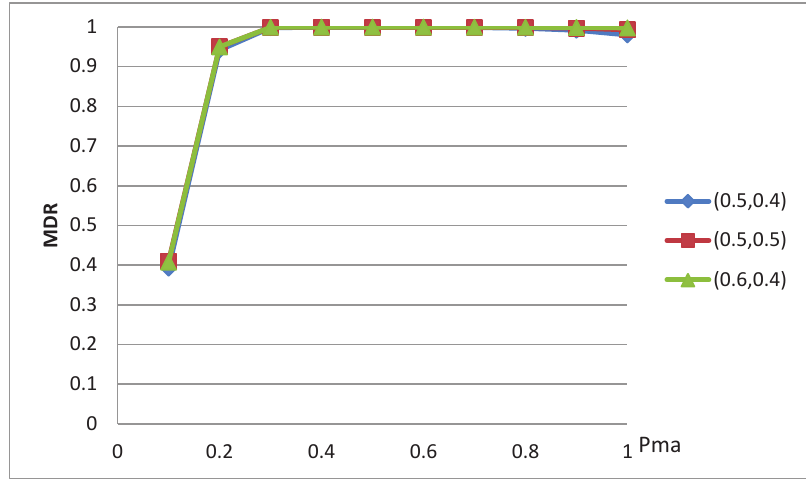
Figure 5. MDR for various values of p